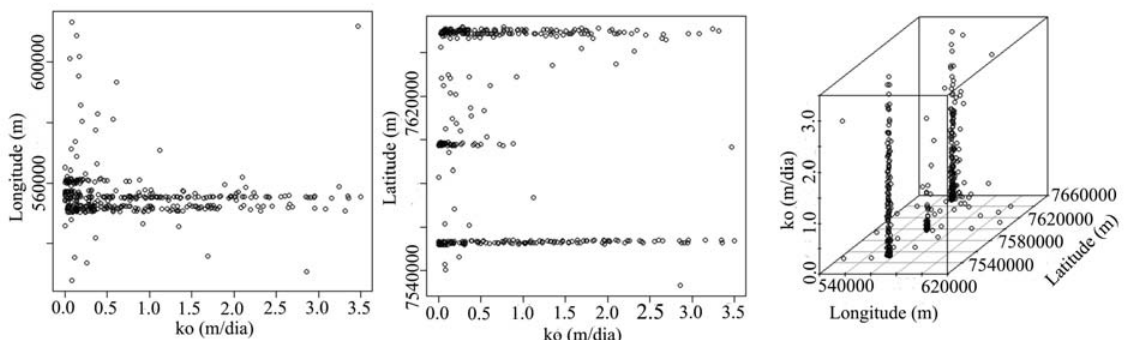
Figura 4. Gráficos de tendência de dados de condutividade hidráulica saturada sem transformação.